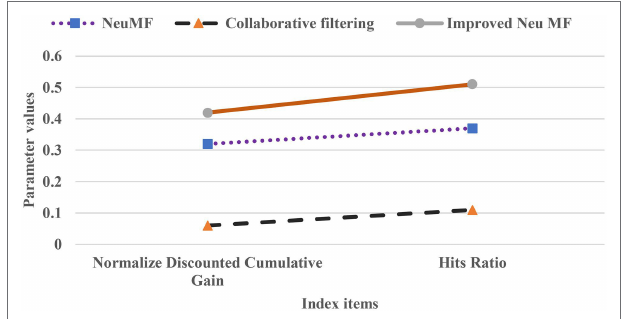
FIGURE 8 | Comparison of the gap between and normalize discounted cumulative gain (NDCG) and